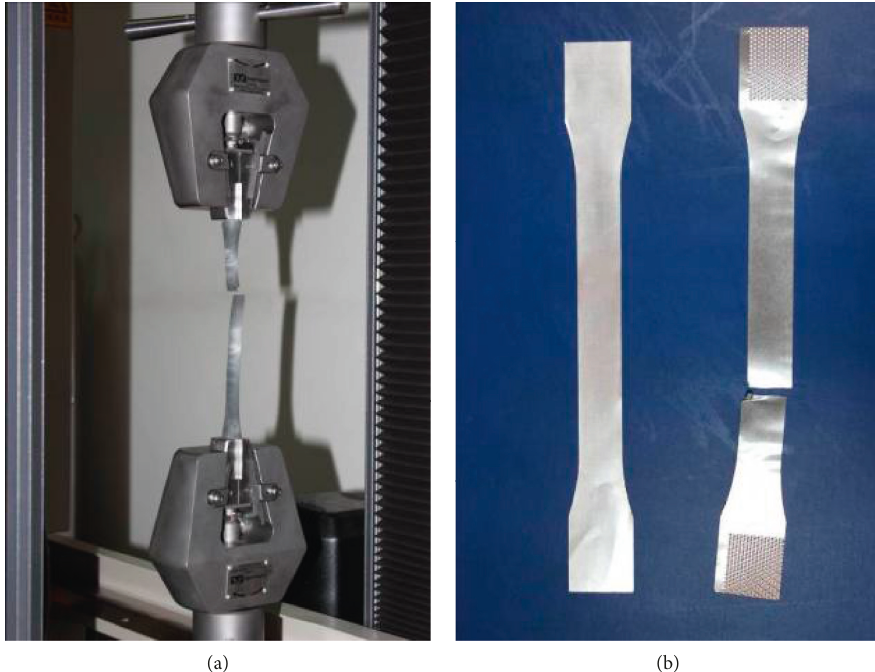
Figure 7: Experiment for the tension test of aluminum foils. (a) Experimental instrument. (b) Experimental specimen.